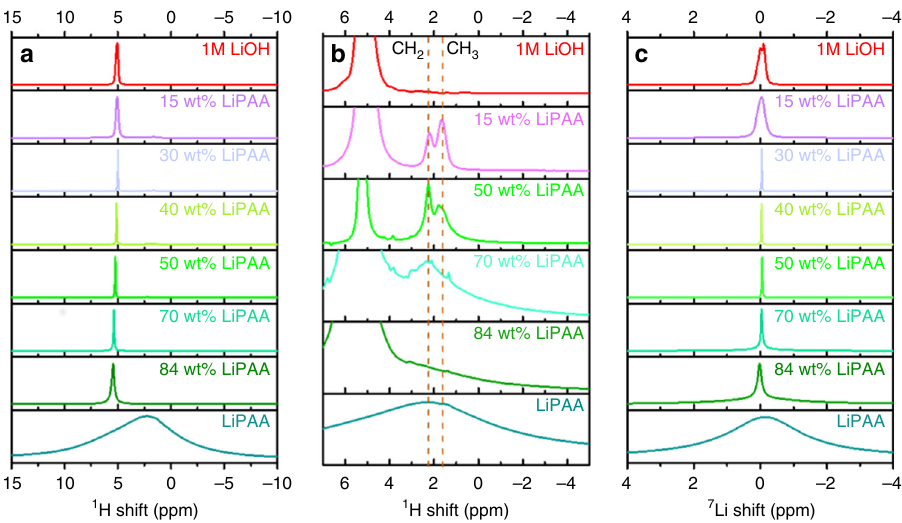
Fig. 3 MAS NMR spectra. a , b 1 H MAS NMR spectra of LiPAA/H 2 O electrolytes, the dashed lines indicating the shift of the “ water ” resonance to lower frequency (blue) and the sharpening of the CH 2 resonance (red) as the water content increases. c 7 Li MAS NMR spectra of the LiPAA/H 2 O electrolytes. All the LiPAA electrolyte spectra were acquired with a spinning rate of 14 kHz while the spectra of 1 M LiOH solution was measured under static